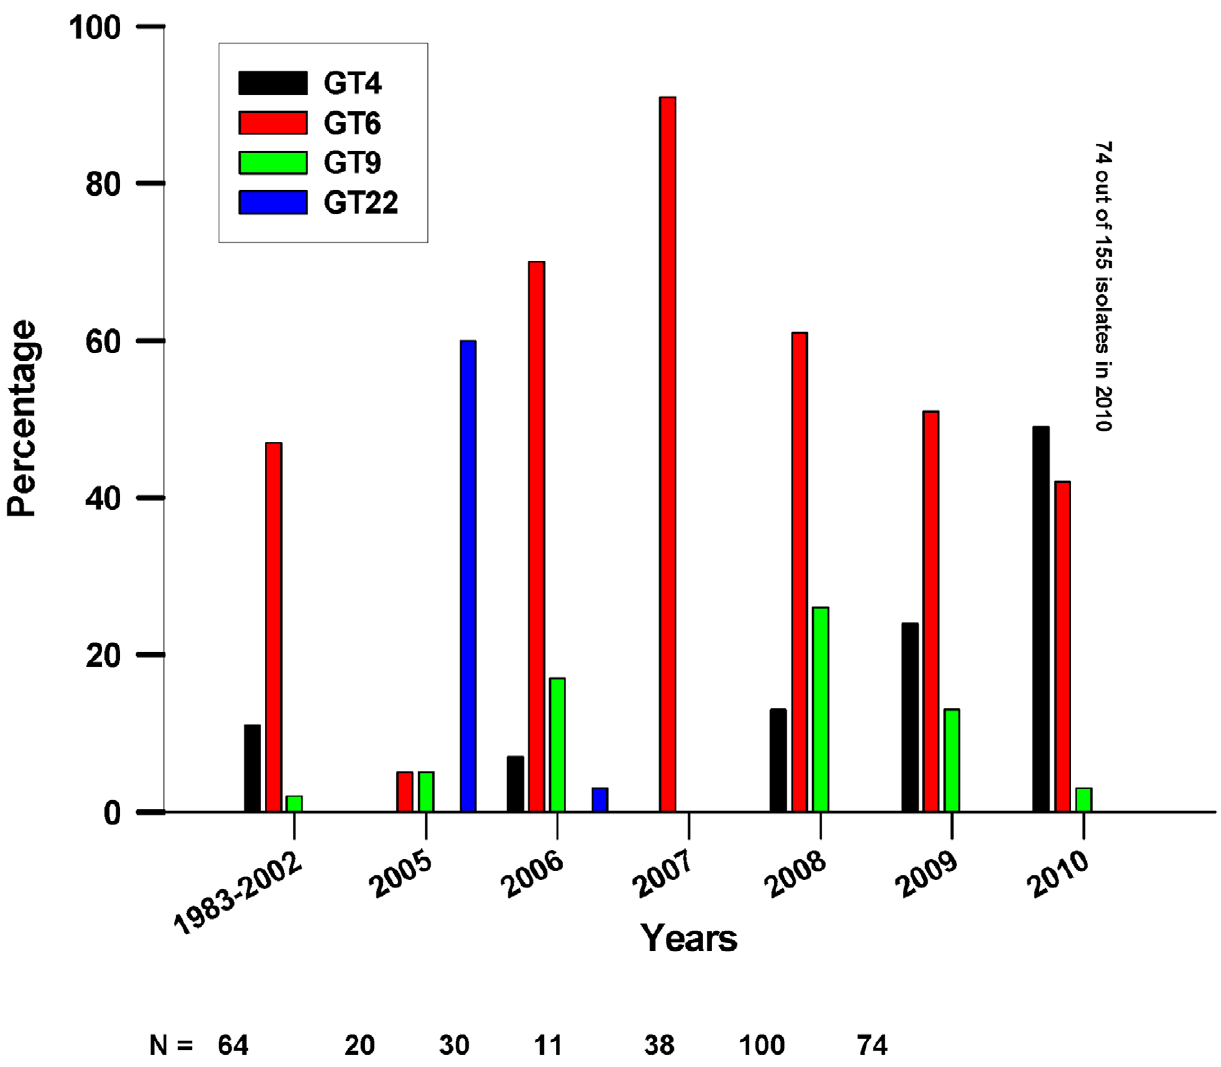
Figure 2. Percentage of isolates of the most prevalent GTs in the ENP per year. Numbers are given for years 2005–2010 when most of the samples were collected. Years 1983, 1987 and 1988–2002, including sampling gaps in 1990, 1993, 1996–99, and 2001, are pooled into the first data point. Total sample sizes are shown below x-axis.